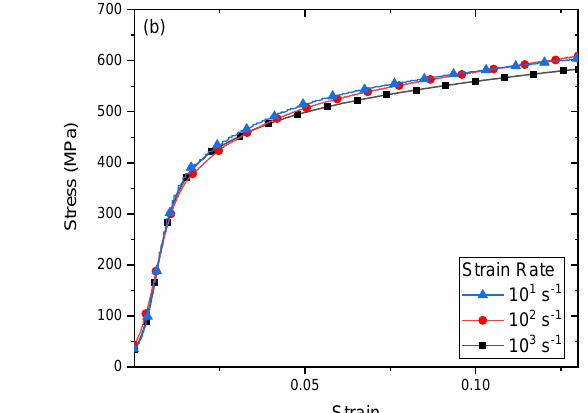
Figure 6. Compression stress-strain curves for Cu-Ta composites consolidated at 300 °C for tests along the extrusion direction (ED), longitudinal direction (LD), and flow direction (FD), ( a ) by route 4E, and ( b ) by route 4Bc.